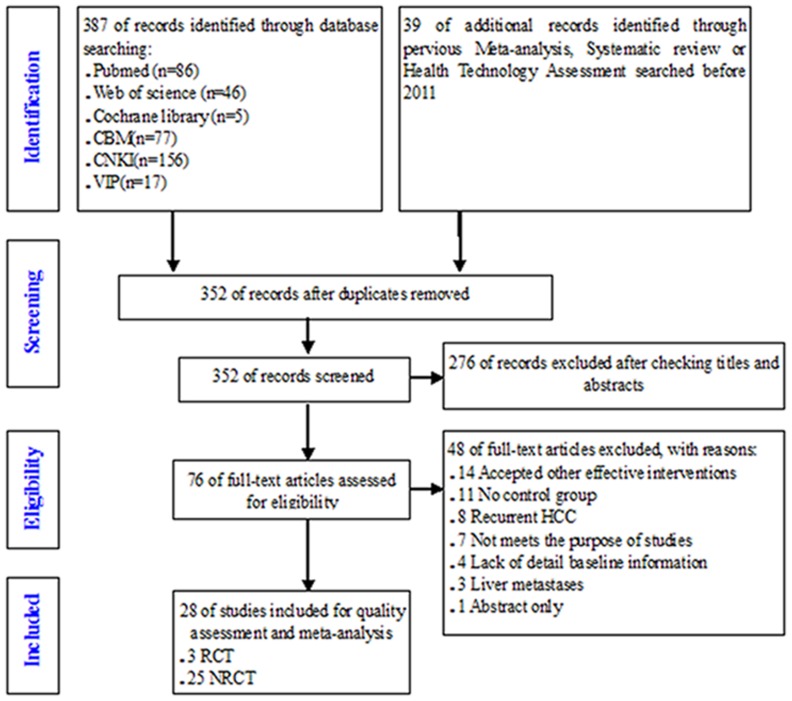
PRISMA flowchart of searching and selecting guidelines.